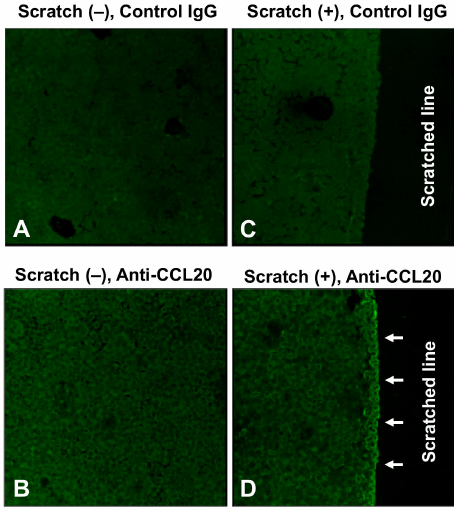
Figure 3. Immunofluorescent visualization of CCL20 at 6 h after scratching. ( A ) Non-scratched control keratinocytes stained with control IgG. ( B ) Non-scratched control keratinocytes stained with anti–CCL20 antibody. ( C ) Scratched keratinocytes stained with control IgG. ( D ) Scratched keratinocytes stained with anti–CCL20 antibody. Original magnification 100 × . Representative data of three independent experiments are